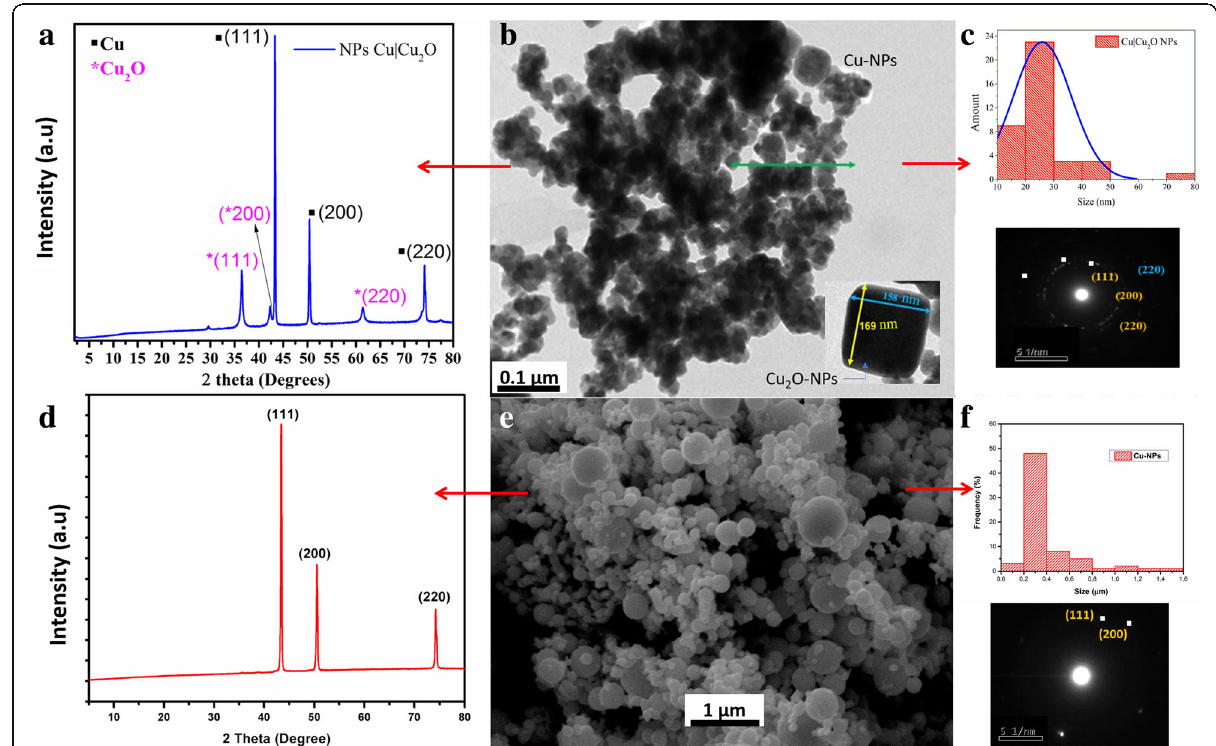
Fig. 1 a XRD of Cu and CuO2 nanoparticles synthesized. b , c TEM image, size distribution, and diffraction pattern of the synthesized nanoparticles. d XRD of Cu nanoparticles. e , f TEM image, size distribution, and diffraction pattern of Cu